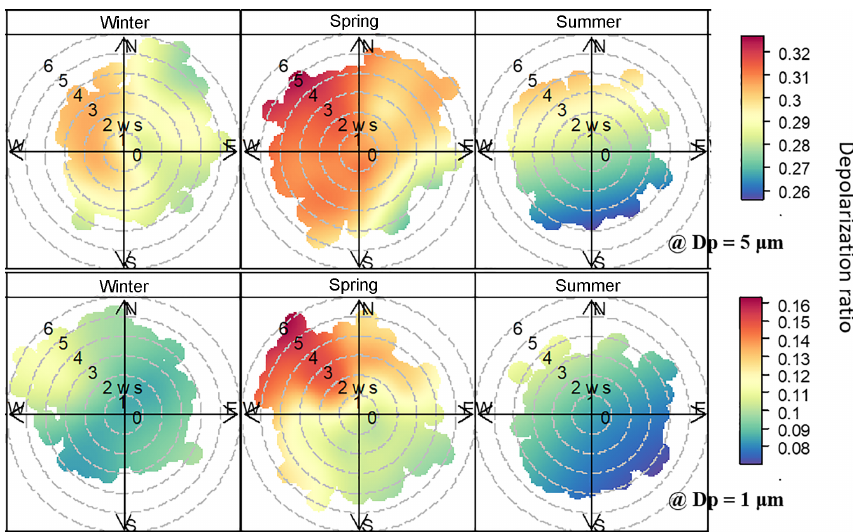
Figure 3. Dependence of the hourly-averaged δ value of particles at Dp = 5 and Dp = 1µm on the wind speed and direction in winter (December, January and February: DJF) 2015, spring (March, April and May: MAM) 2016 and summer (June and July: JJ)